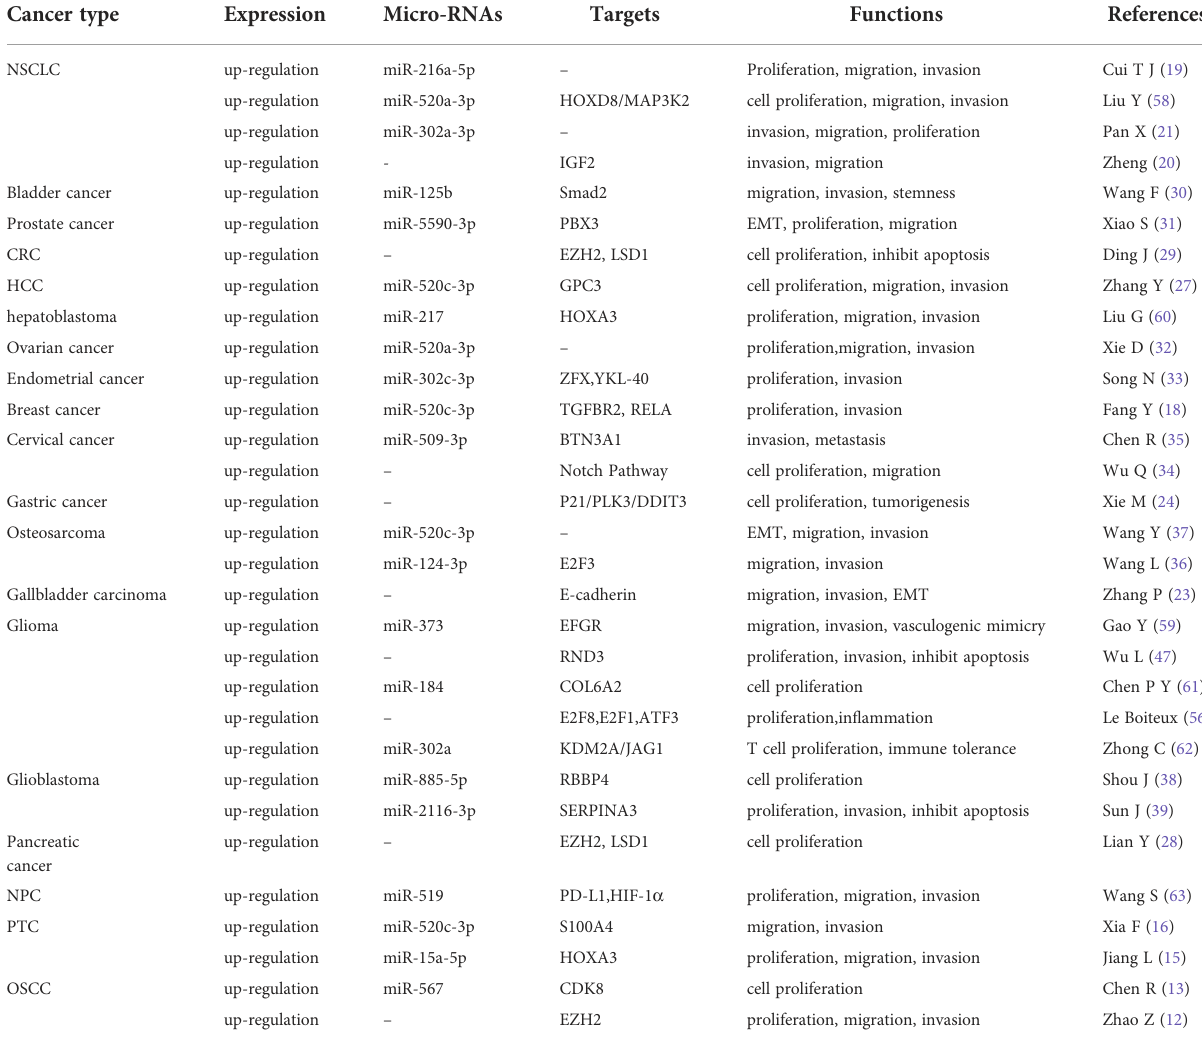
TABLE 3 Regulation mechanism of HOXA-AS2 involved in various solid